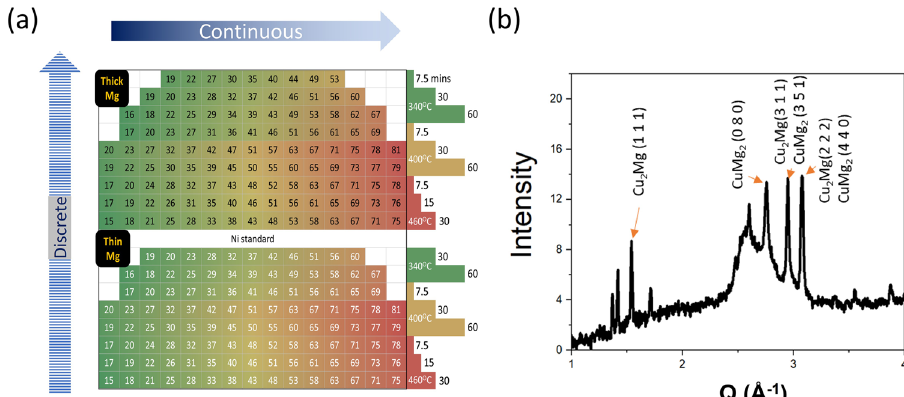
Fig. 4 Sample layout for XRD measurement and XRD result. a Sample layout for a series of combinatorial thin- fi lm samples with four controlled parameters: parent alloy composition (Ti ~20 – 80 at.% in a Ti-Cu parent alloy), Mg dealloying agent fi lm thickness (250 and 450 nm), dealloying time (7.5, 15, 30, and/or 60 min, depending on the dealloying temperature) and temperature (340, 400 and 460 °C). The numbers in each grid indicate atomic concentration of Ti in the parent alloy fi lm. b XRD pattern from a sample dealloyed at 400°C for 60 min, after subtracting the glass background.